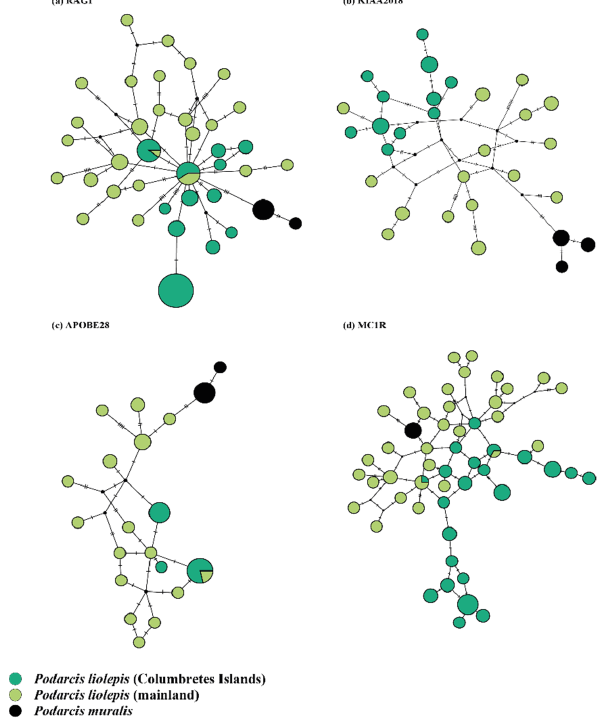
Figure 5. TCS haplotype networks of P. liolepis samples from both the Columbretes Islands and from the mainland of the Iberian Peninsula for the four nuclear loci studied: RAG1 ( a ), KIAA2018 ( b ), APOBE28 ( c ), and MC1R ( d ). Podarcis muralis was included as an outgroup; black nodes are the inferred intermediate haplotypes. Table 2. List of identified diet taxa to the maximum resolution obtained in the diet composition of Podarcis liolepis from Columbretes Grossa through molecular